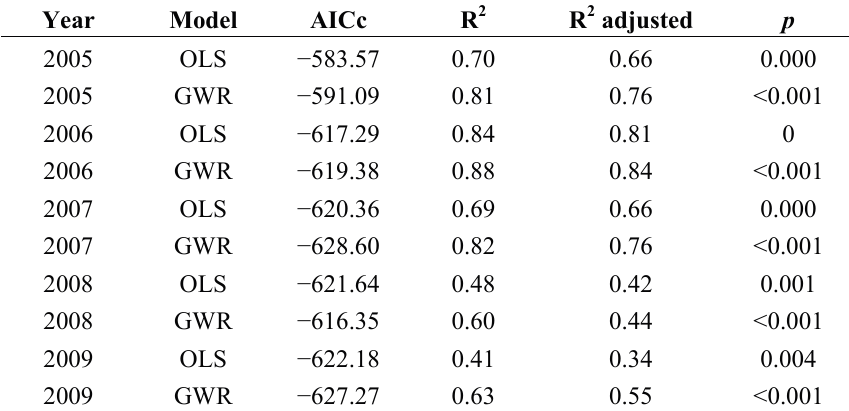
Table 4. Comparison of the OLS and GWR models.